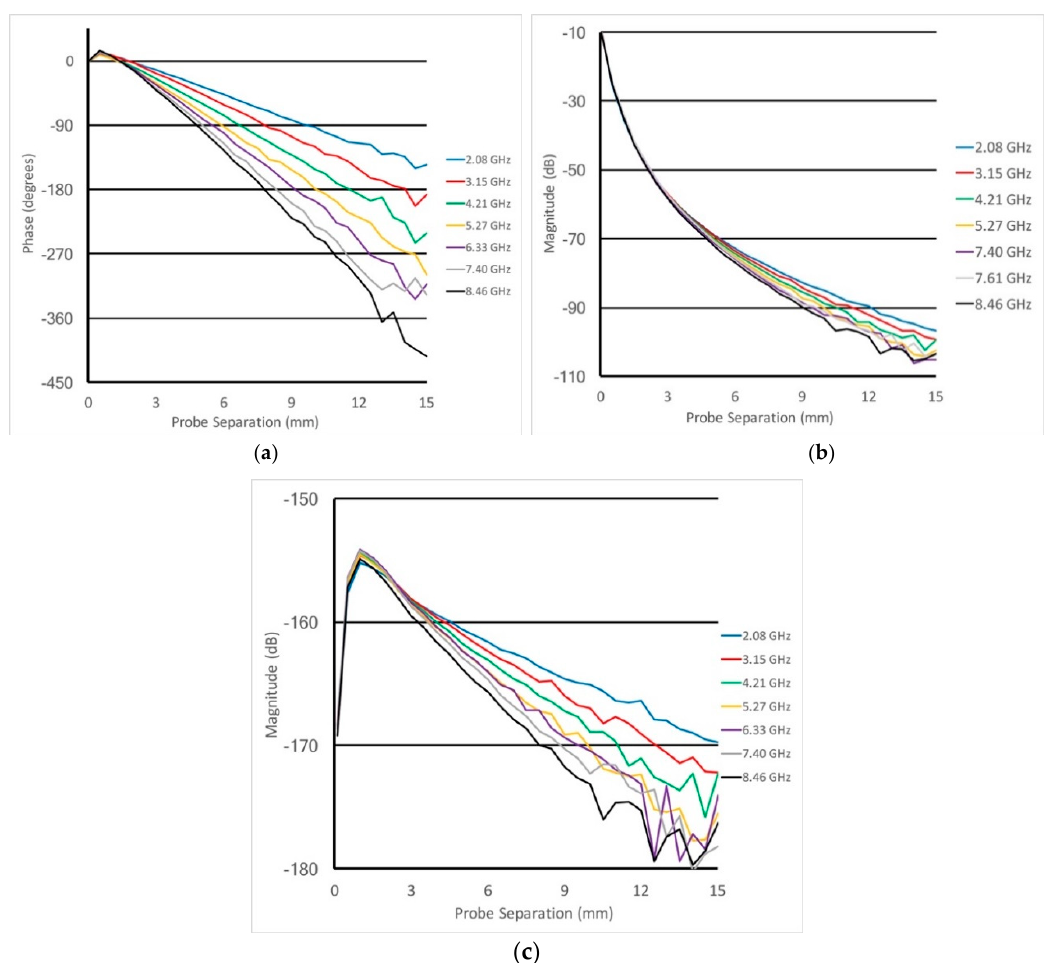
Figure 4. Plots of the ( a ) phases and ( b ) magnitudes as a function of separation distances for several representative frequencies across the 2–8 GHz band. ( c ) shows the magnitude plots after compensation from the technique described in Equation (3).